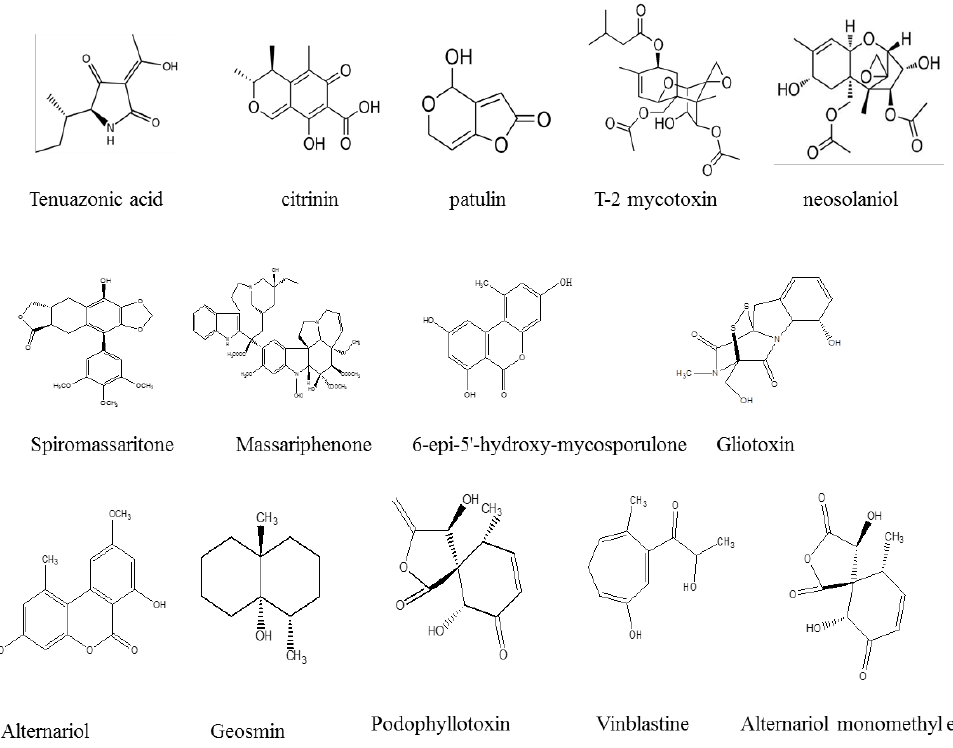
Figure 1. The toxic metabolites produced by aquatic fungal Figure 1. T he toxic metabolites produced by aquatic fungal species.